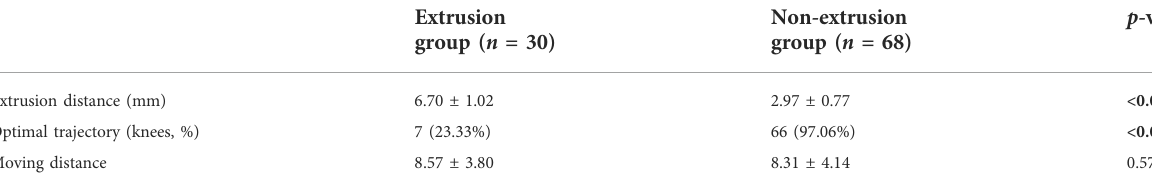
TABLE 2 Comparison of the intraoperative measures on the movement trajectory of the meniscus bearing between the two groups.